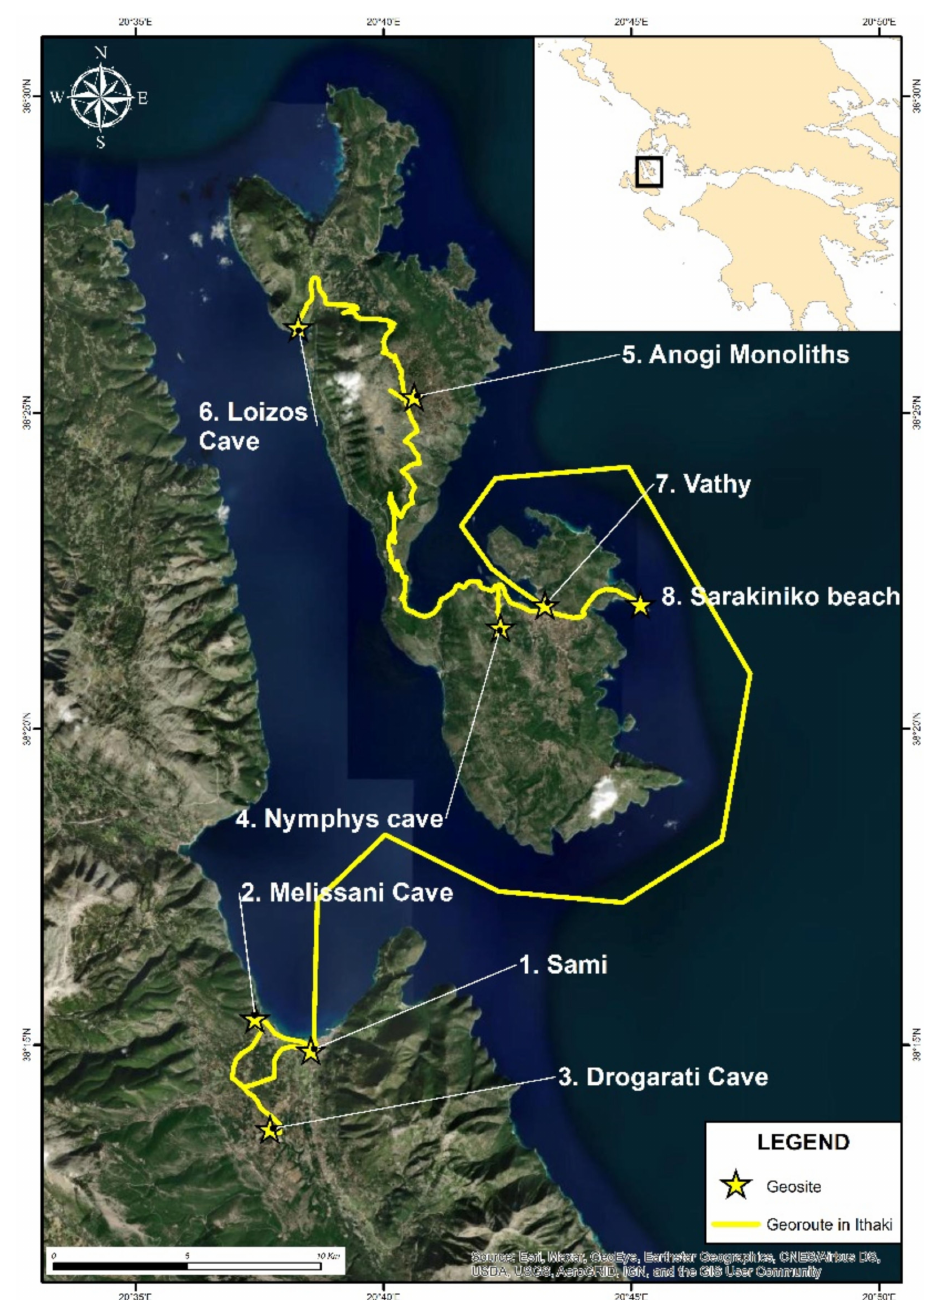
Figure 16. Kefalonia and Ithaki inter-island